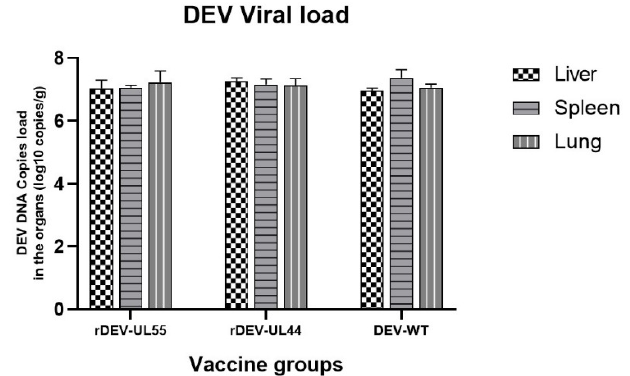
Figure 1. DEV viral load in organs infected with rDEV-OmpH-UL55, rDEV-OmpH-UL44 or DEV-WT. All the ducks in the three groups were humanely euthanized on day 7 post-inoculation, and their organs (liver, spleen and lungs) were obtained to determine virus titers using a one-step real-time PCR assay. ( p < 0.05).